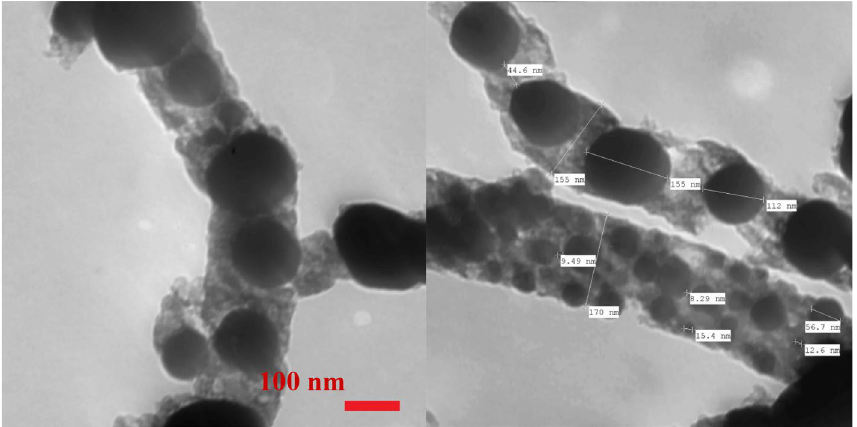
Figure 4. TEM image of Mo 2 C/Ni/graphite composite nanofibers prepared from an electrospun solution containing 10% molybdenum precursor at 850